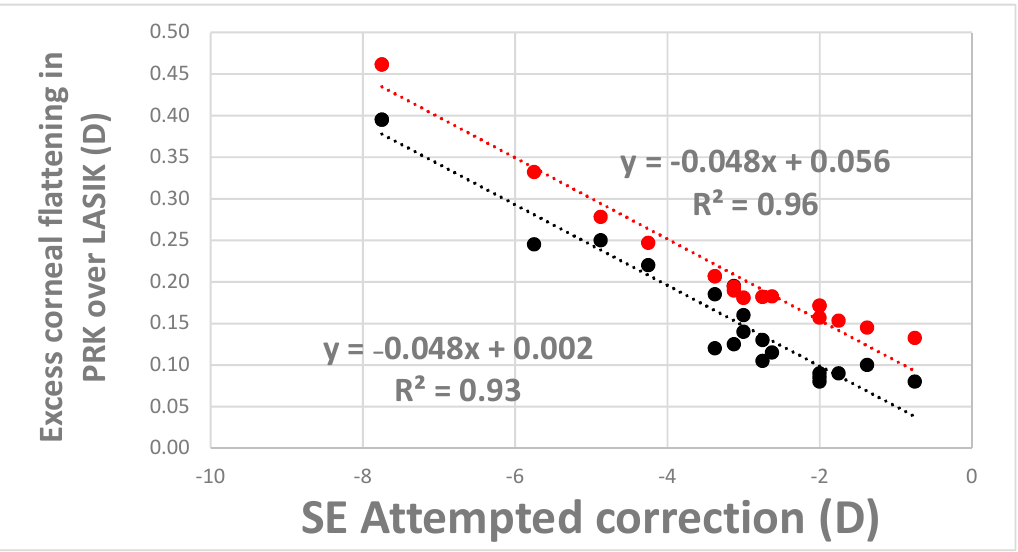
Figure 2. Additional corneal flattening observed in PRK over those observed in LASIK from simulations (black group), and global historical nomogram (red group) plotted as a function of attempted spherical equivalent (SE) refractive error. (D: Diopters). Table 2. The differences between post-PRK and post LASIK in K steep : simulated keratometry steep principle axis, K flat : simulated keratometry flat principle axis, Kaverage: average simulated keratometry, MPS: maximum principal strain in response to the corresponding photoablation